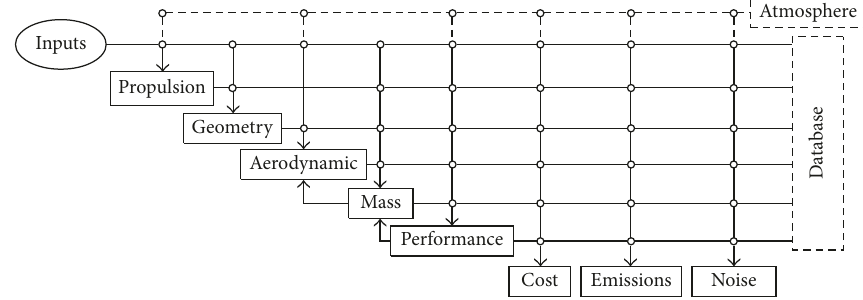
Figure 1: Framework of multidisciplinary